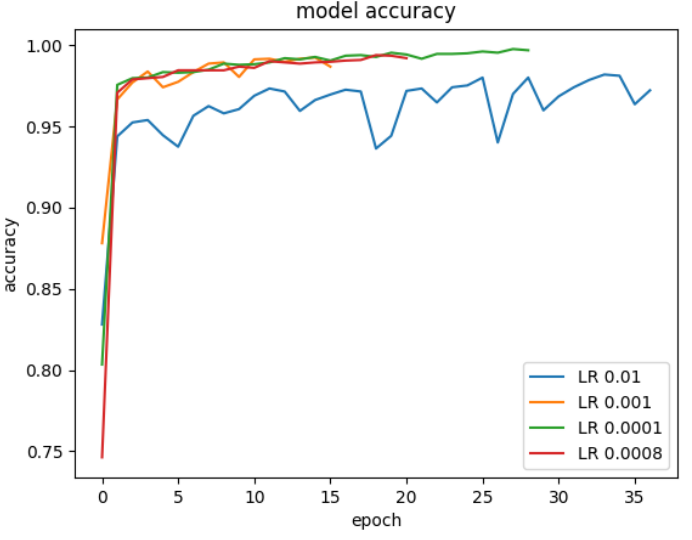
Figure 15. The accuracy of the model on various learning